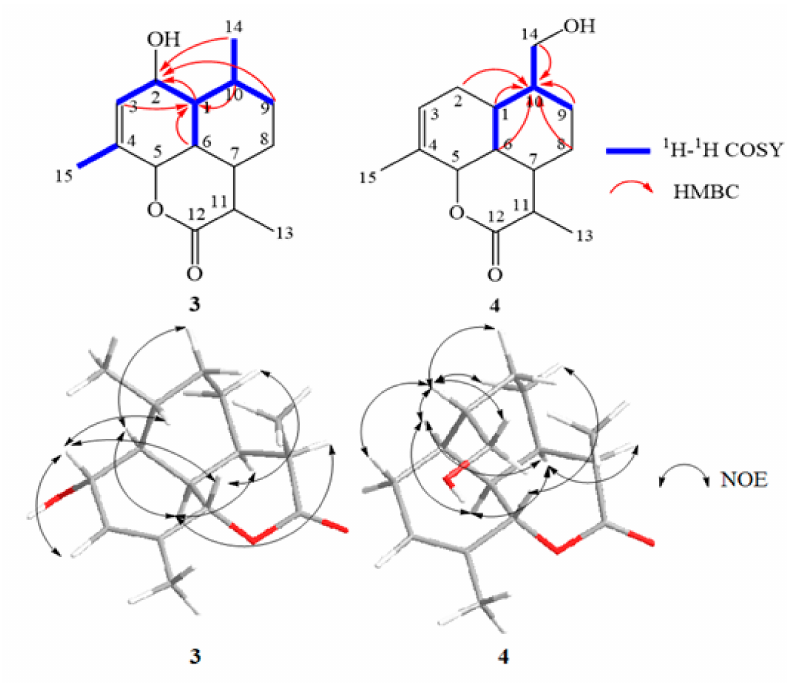
Figure 6. Key COSY, HMBC and NOE correlations of compounds 3 and 4